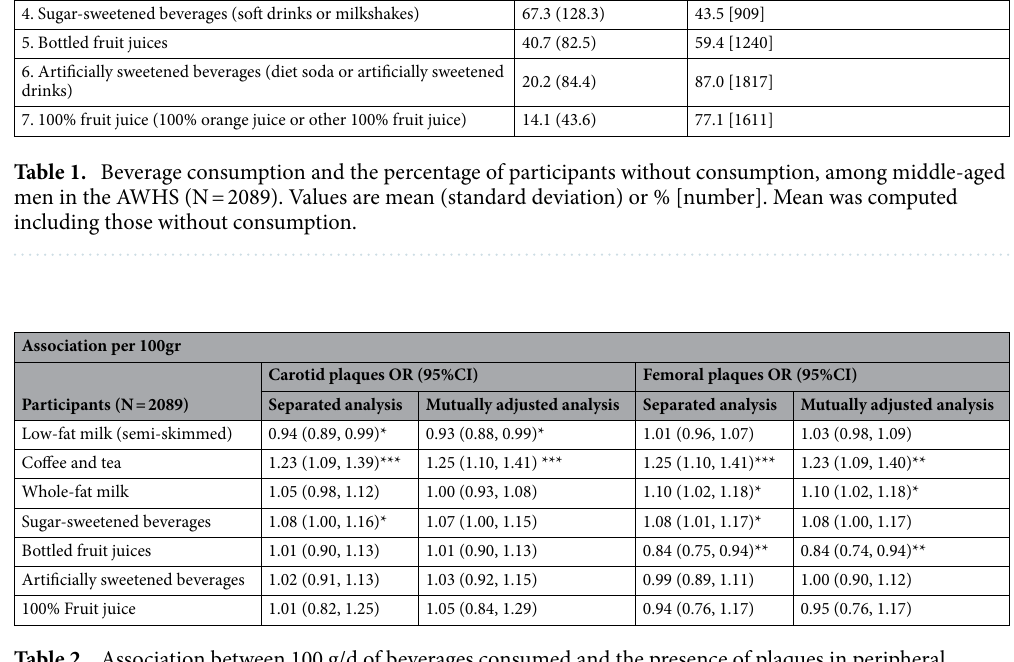
Table 2. Association between 100 g/d of beverages consumed and the presence of plaques in peripheral arteries among participants in the AWHS. AWHS, Aragon Workers’ Health Study; OR, odds ratio; CI, confidence interval. N, total number of participants. Asterisks denote P value: *** p ≤ 0.001, ** p ≤ 0.01, * p ≤ 0.05. † Adjusted for age, BMI, smoking status (ever smoker or never smoker), alcohol consumption (gr/ day), hypertension, dyslipidemia, diabetes and total METs-h/week. The mutually adjusted analysis included all beverage groups simultaneously in the same regression